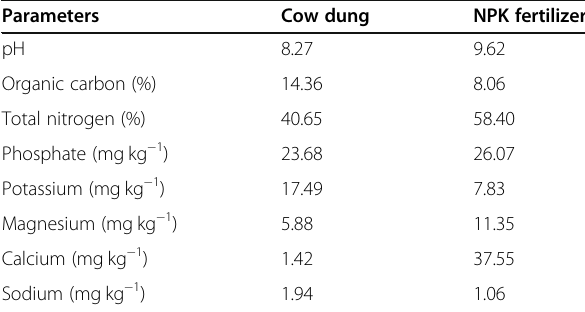
Table 2 Properties of NPK fertilizer and cow dung used